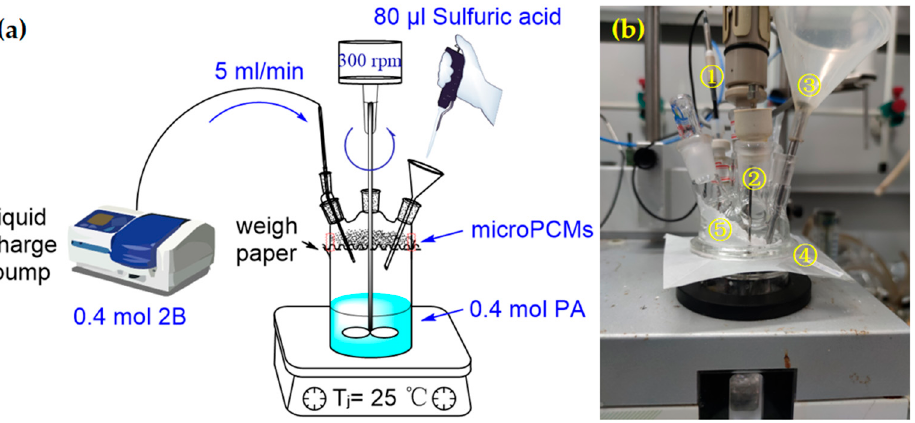
Figure 9. ( a ) Experimental process and ( b ) experimental equipment for temperature control experiments using the microPCMs.